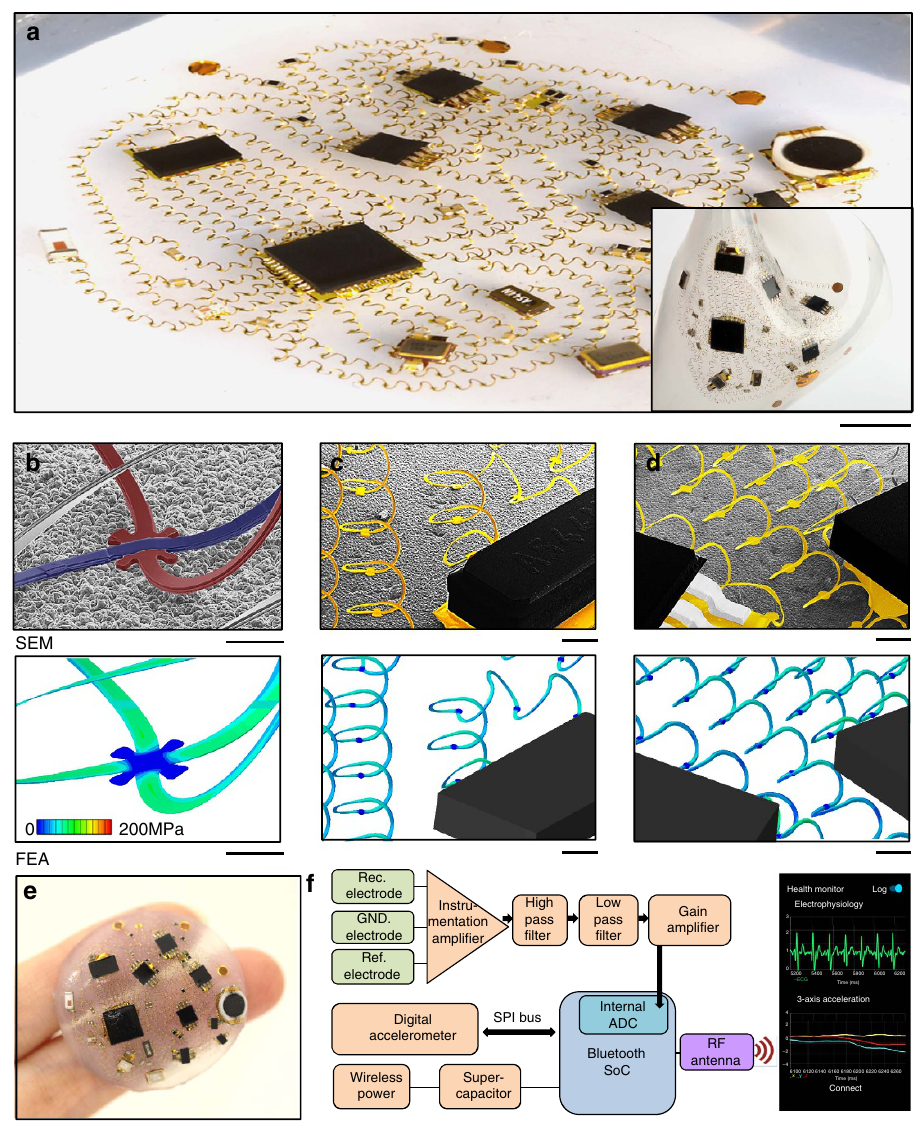
Figure 2 | Three-dimensional network of helical coils as electrical interconnects for soft electronics. ( a ) Optical image of the system at a bi-axially stretched state of 50%, showing B 250 3D helices, B 500 bonding sites, B 50 component chips and elastomers for full encapsulation (Encapsulation material: Silbione 4717A/B, Bluestar Silicones, France; E ¼ 3kPa; bottom substrate: Ecoflex 00-50A/B, Smooth-on, USA; E ¼ 20kPa) Inset: optical image